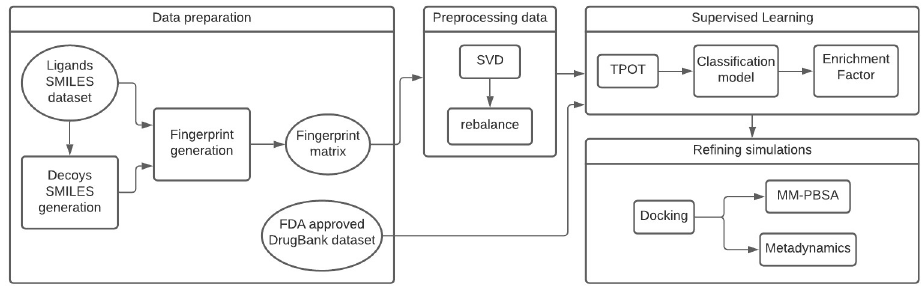
Fig 1. The workflow of our strategy. It is composed of four blocks: Data preparation; Preprocessing data; Supervised learning; and Refining simulations. Rectangles indicate processing steps and ellipsoids denote datasets.